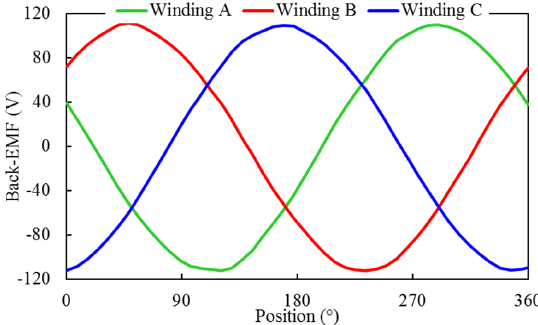
Figure 17. Back-EMF at the speed of 600 r/min.